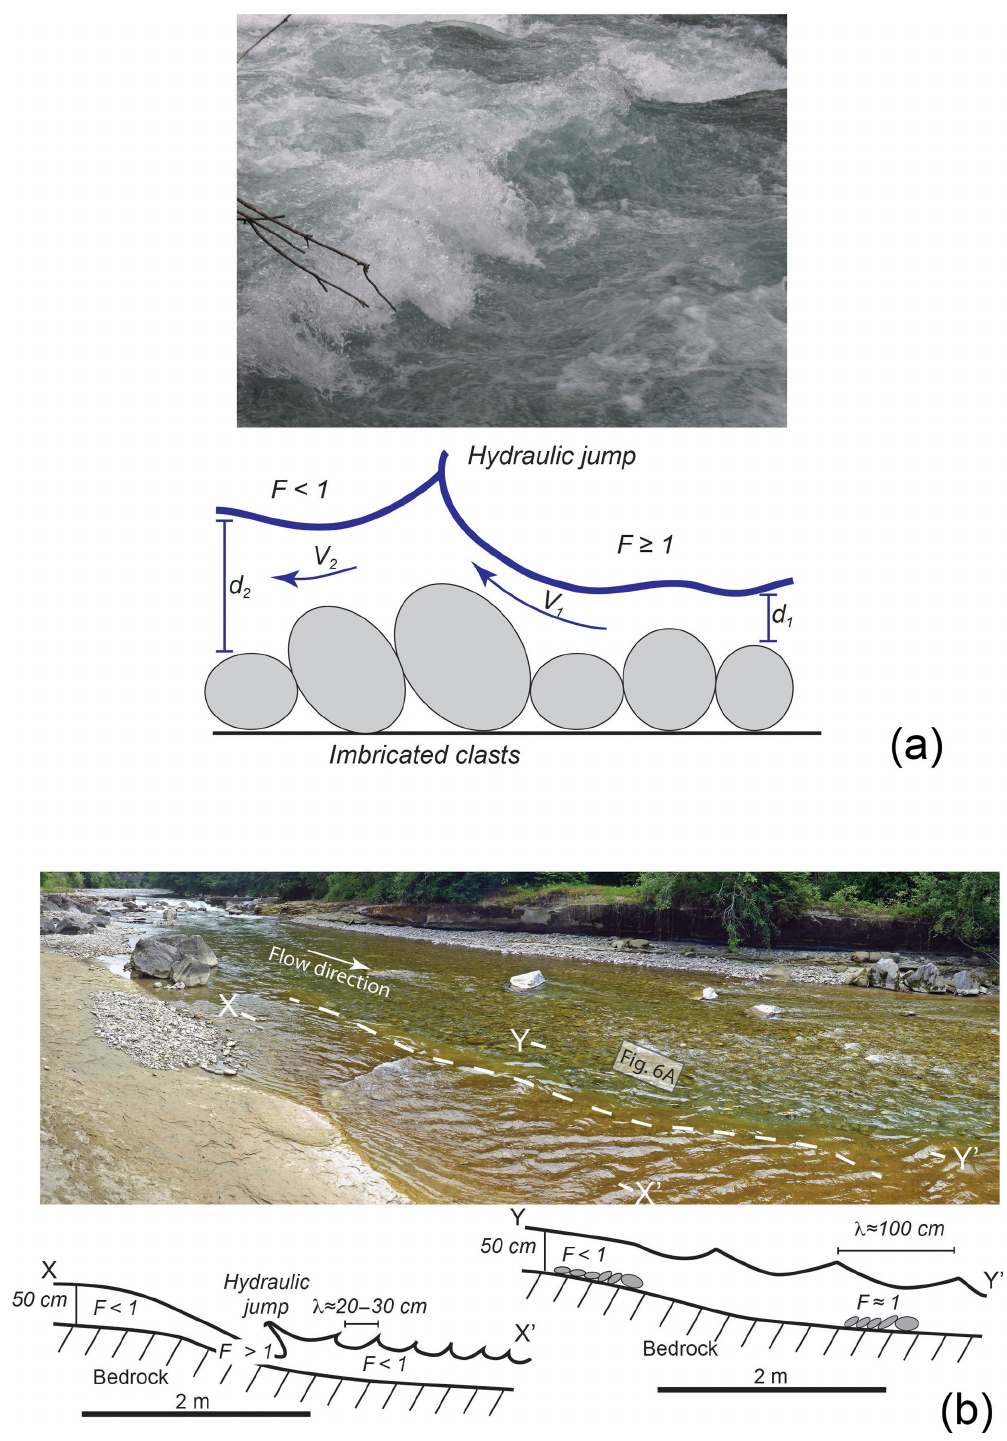
Figure 1. (a) Photo showing hydraulic jump, and conceptualization of the situation displayed in (a) . F is the Froude number; v is the flow velocity; d is the water depth. (b) Photo from Sense river, and cross sections through reaches with upper and lower flow regimes. Surface waves ( λ ≈ 20–30cm) tend to fade out towards the upstream direction relative to the flow movement where subcritical flows prevail (section to the left). A hydraulic jump separates supercritical from subcritical flow where the bedrock builds a ramp. The reach illustrated by the section to the right is characterized by standing waves with wavelengths λ ≈ 100cm. The dashed line illustrates the trace of the plane that separates lower from upper regime flows. Please see Fig. 2 for location of